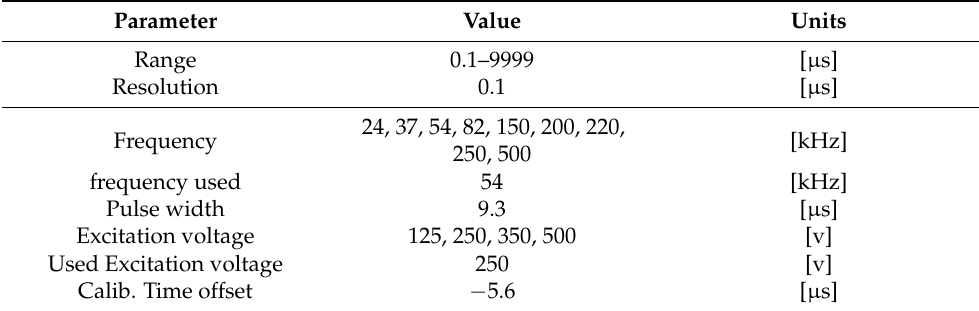
Table 5. Measuring device